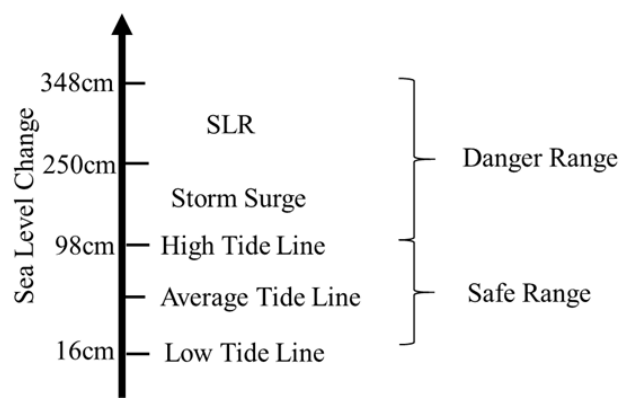
Figure 33. Schematic diagram of danger range of sea level change.